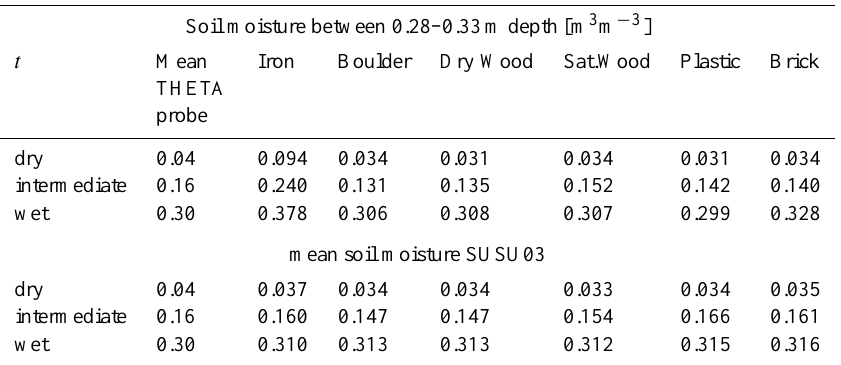
Mean Iron Boulder Dry Wood